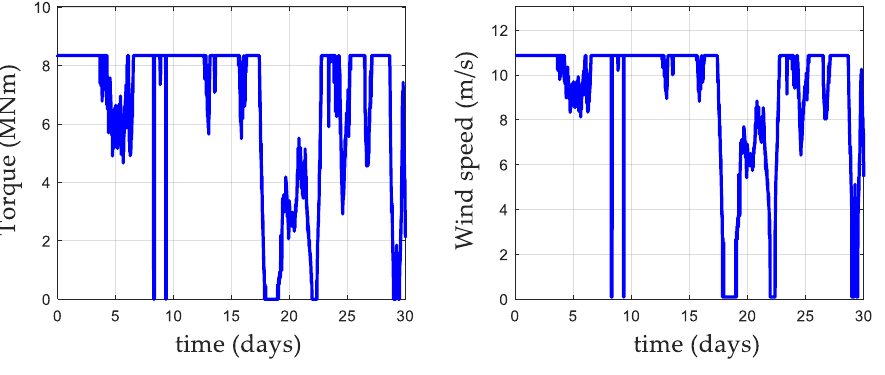
Figure 5. Typical power curve of a pitch-controlled wind turbine.